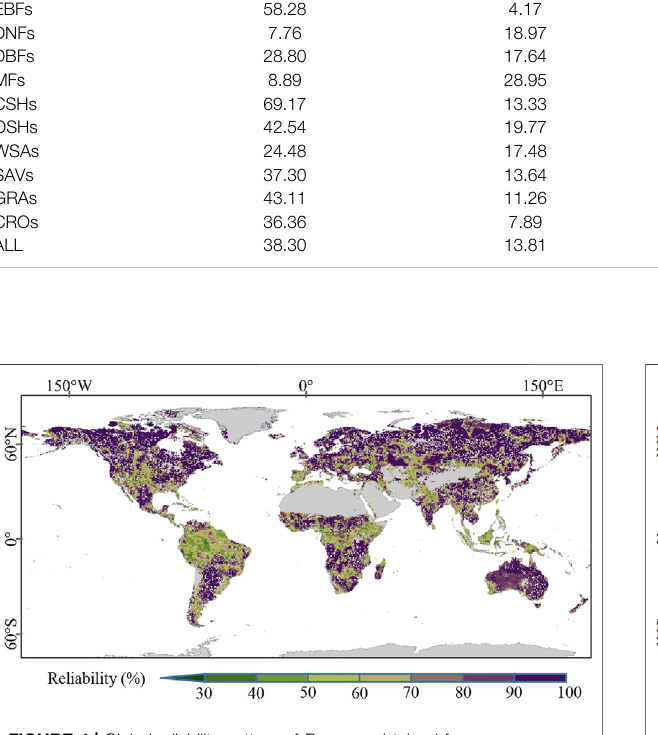
FIGURE 4 | Global reliability pattern of R max-cum obtained from probability statistic.